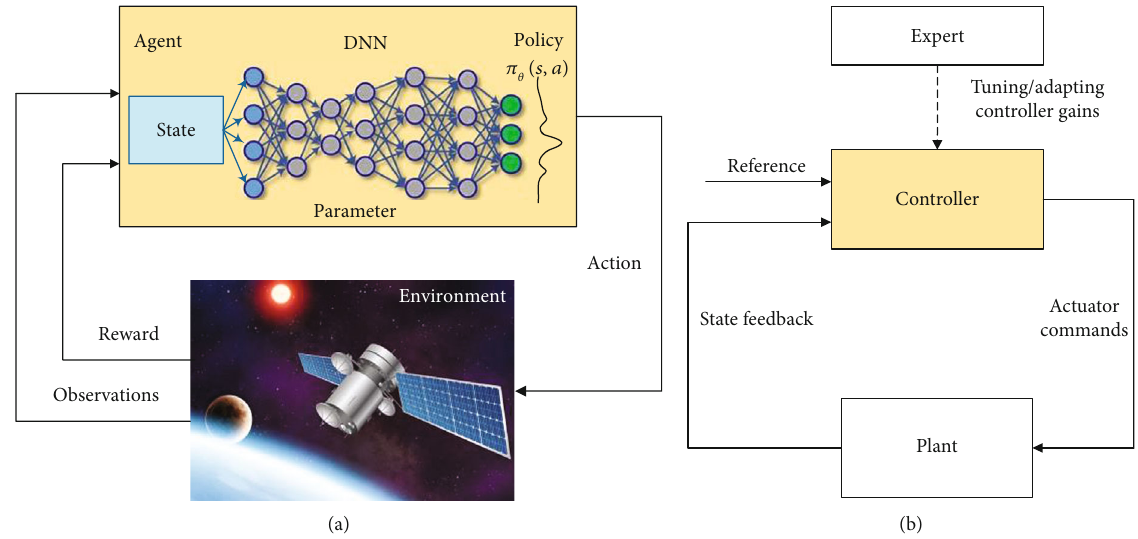
Figure 2: These are the schematics of the controllers: (a) controller based on deep reinforcement learning; (b) traditional